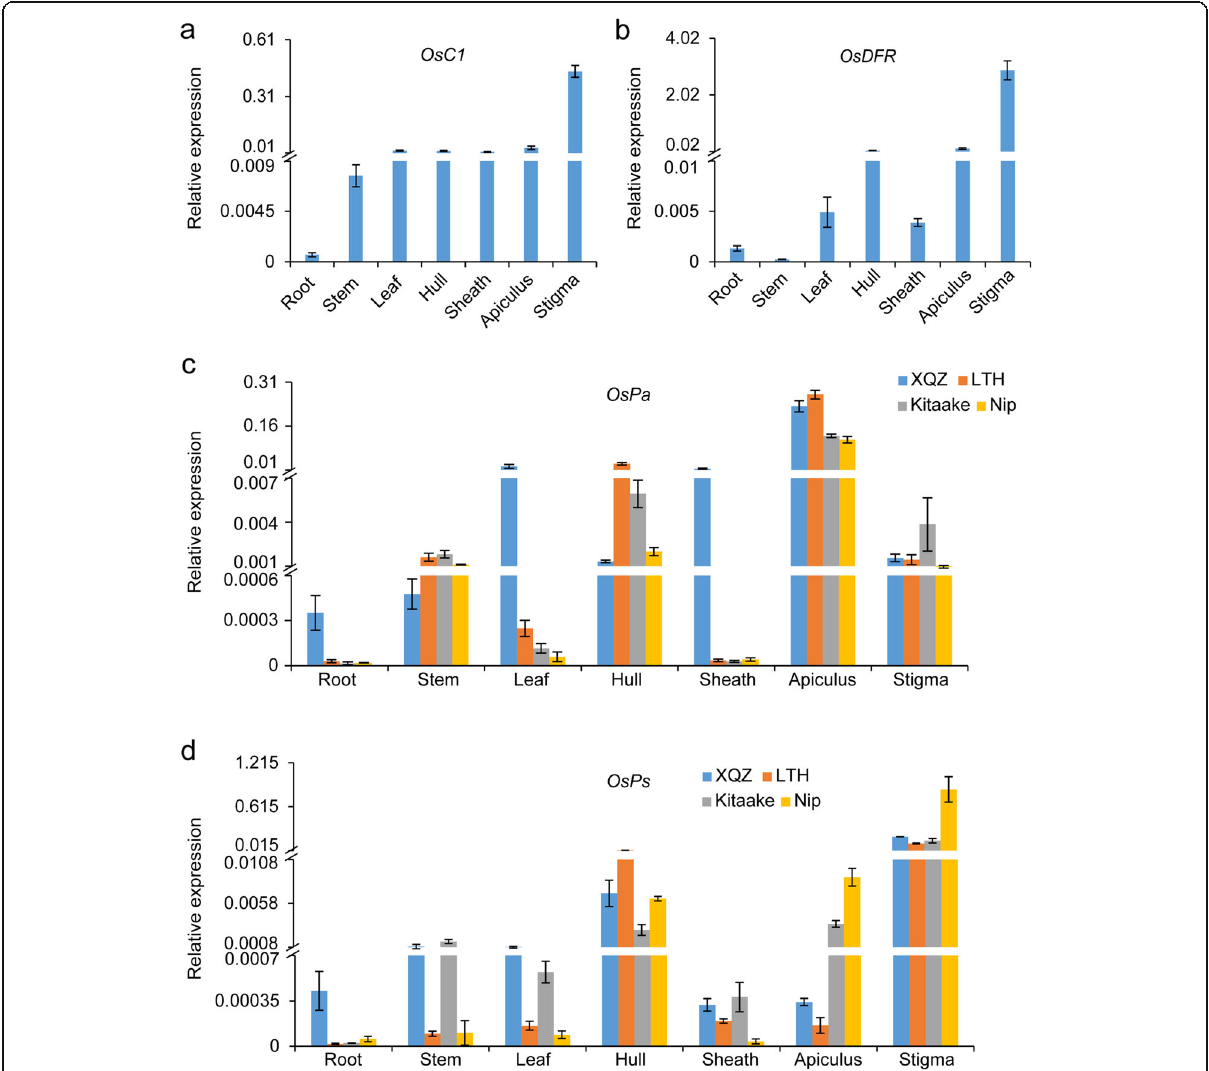
Fig. 4 Expression patterns of OsC1 , OsDFR , OsPa and OsPs . Expression analysis of OsC1 ( a ), OsDFR ( b ) in XQZ. Expression patterns of OsPa ( c ) and OsPs ( d ) in XQZ, LTH, Kitaake and Nipponbare (Nip). The samples were collected from roots of 10-day-old seedlings, stems, flag leaves, hulls, leaf sheaths, apiculi, and stigmas at heading, respectively. Data are presented as means ± SD ( n =